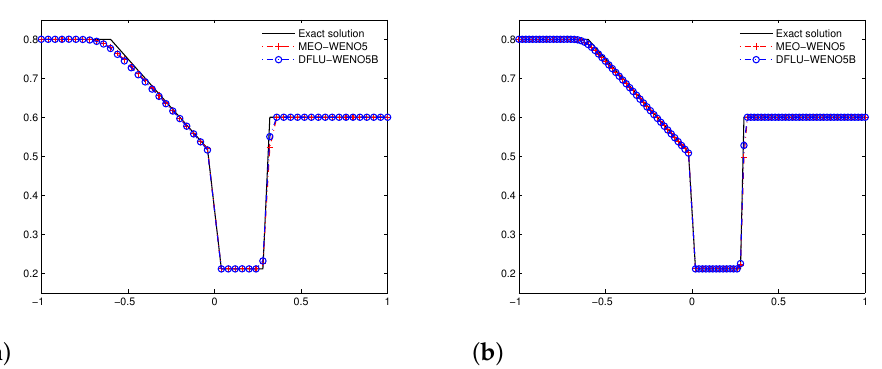
Figure 6. Example 1 computed by the MEO-WENO5 and DFLU-WENO5B with different meshes. ( a ): ∆ x = 1/25; ( b ): ∆ x =